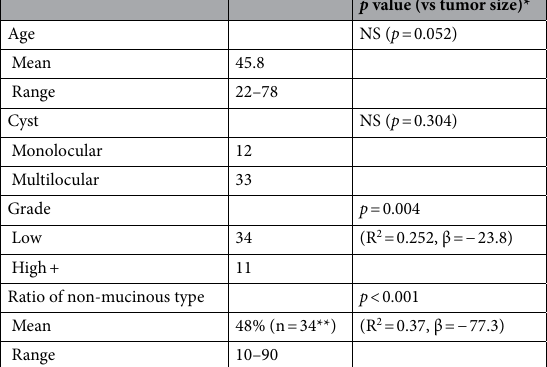
Table 1. The relationship between clinicopathological data and tumor size of pancreatic MCN. * p value, R 2 score (contribution rate), and β-value (coefficient) by regression/logistic analysis were shown. **Ratio of non- mucinous type epithelium was analyzed for low grade-MCN cases (n = 21). MCN, mucinous cystic neoplasm.